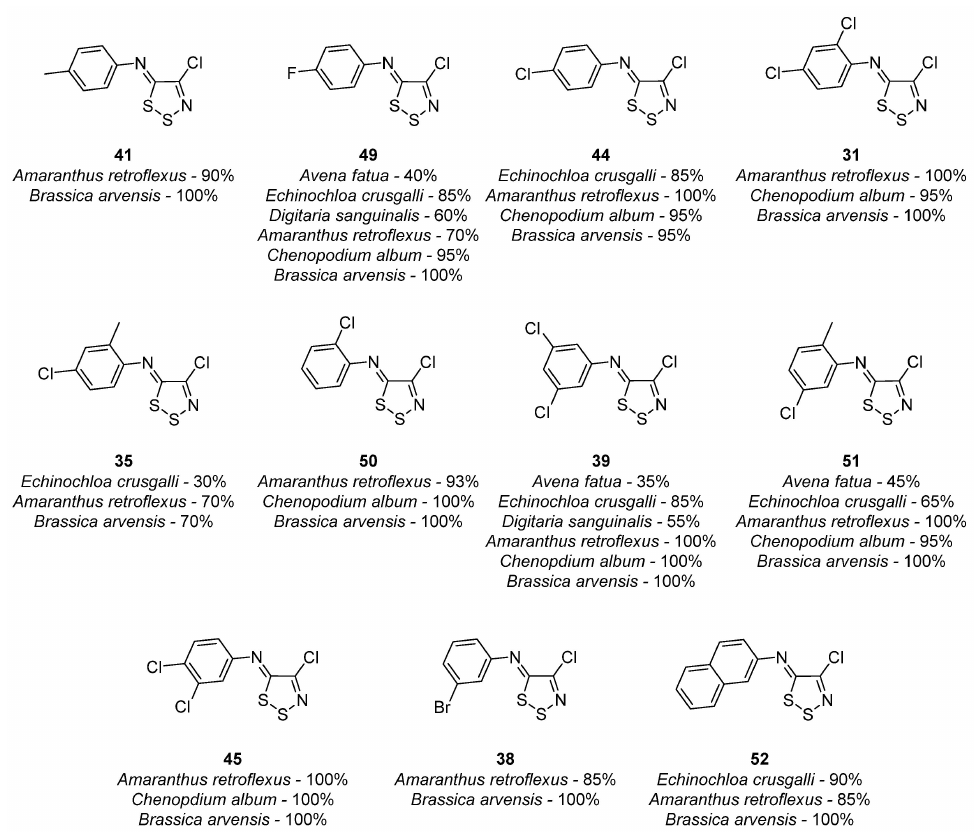
Figure 5. Herbicidal activities of early 1,2,3-dithiazole derivatives tested at 33